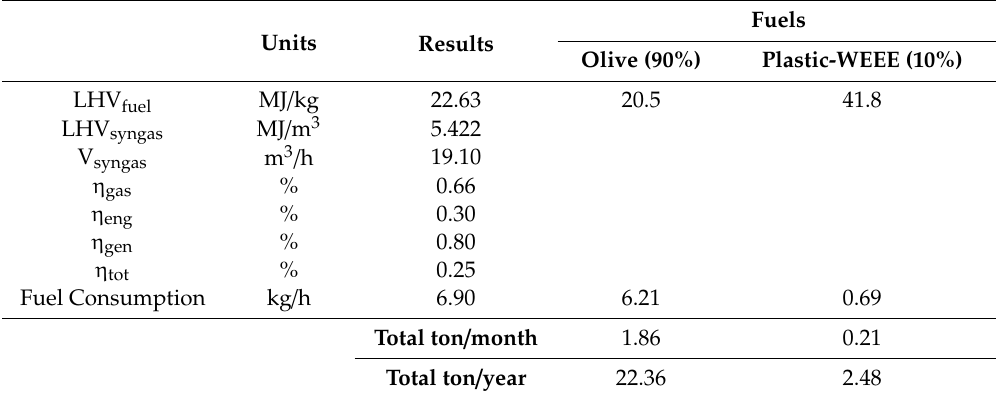
Table 12. Results for 90% olive and 10% plastic. (Source: